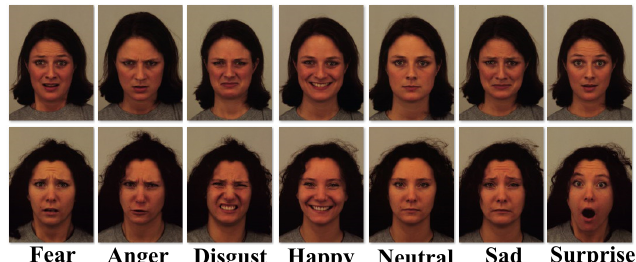
Figure 1. Example of seven types of facial expressions for the FER